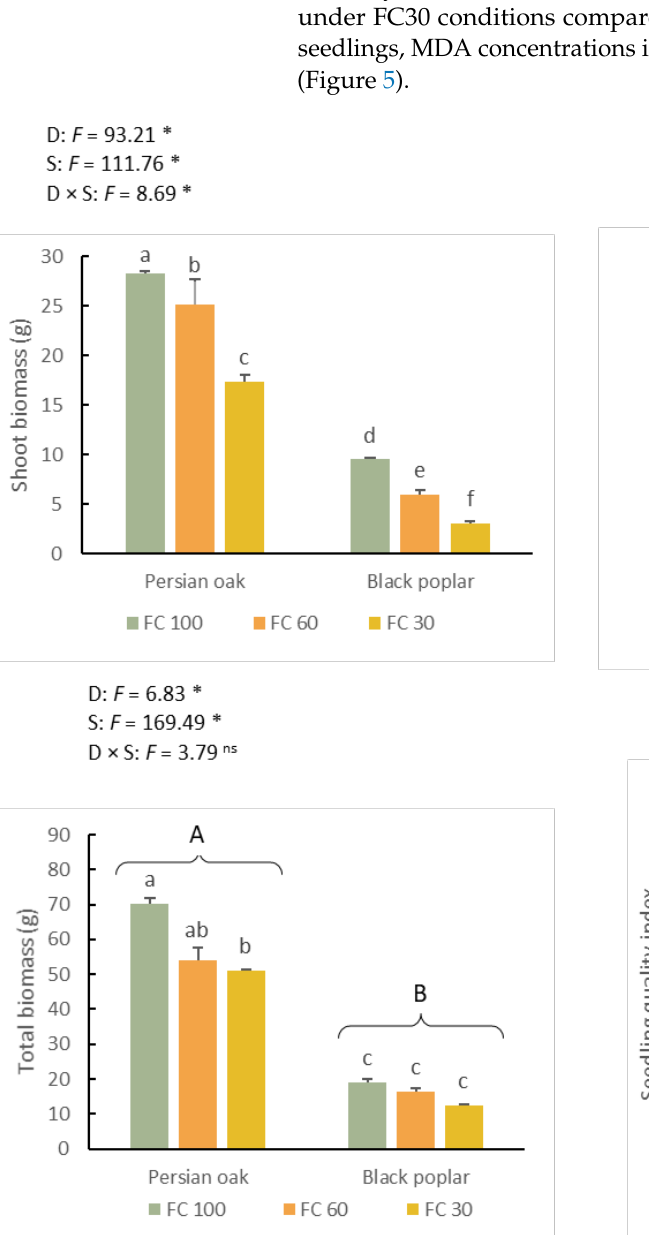
Figure 3. Shoot, root, and total biomass along with the Dickson quality index of Persian oak and black poplar seedlings as a function of soil water deficit. Means ± standard deviation, n = 3 blocks. Different lower-case letters indicate statistically significant differences based on Duncan’s multiple range post-hoc test ( α = 0.05). In the presence of a significant interaction between drought (D) and species (S), the significance letters are valid across species but only remain valid within species when the interaction (D × S) was not significant. Different upper-case letters indicate statistically significant differences between species in the absence of a significant D × S interaction. * p < 0.05.